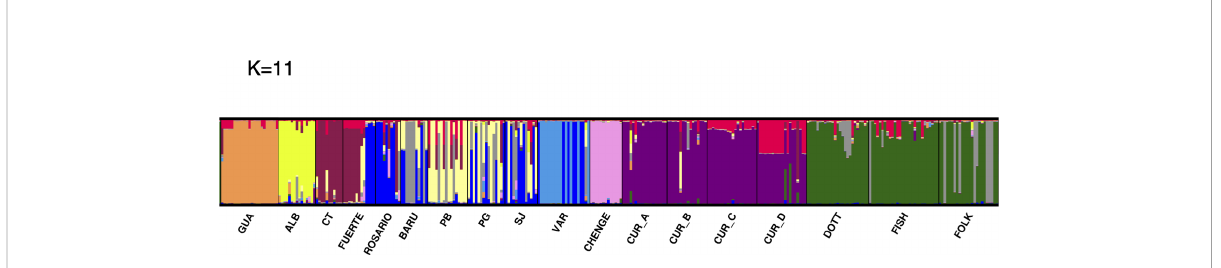
FIGURE 1 Clusters of M. auretenra in the Caribbean Sea. It shows the individual membership coef fi cients for M. auretenra to the clusters (K) as inferred by STRUCTURE for all studied sites with K= 11.